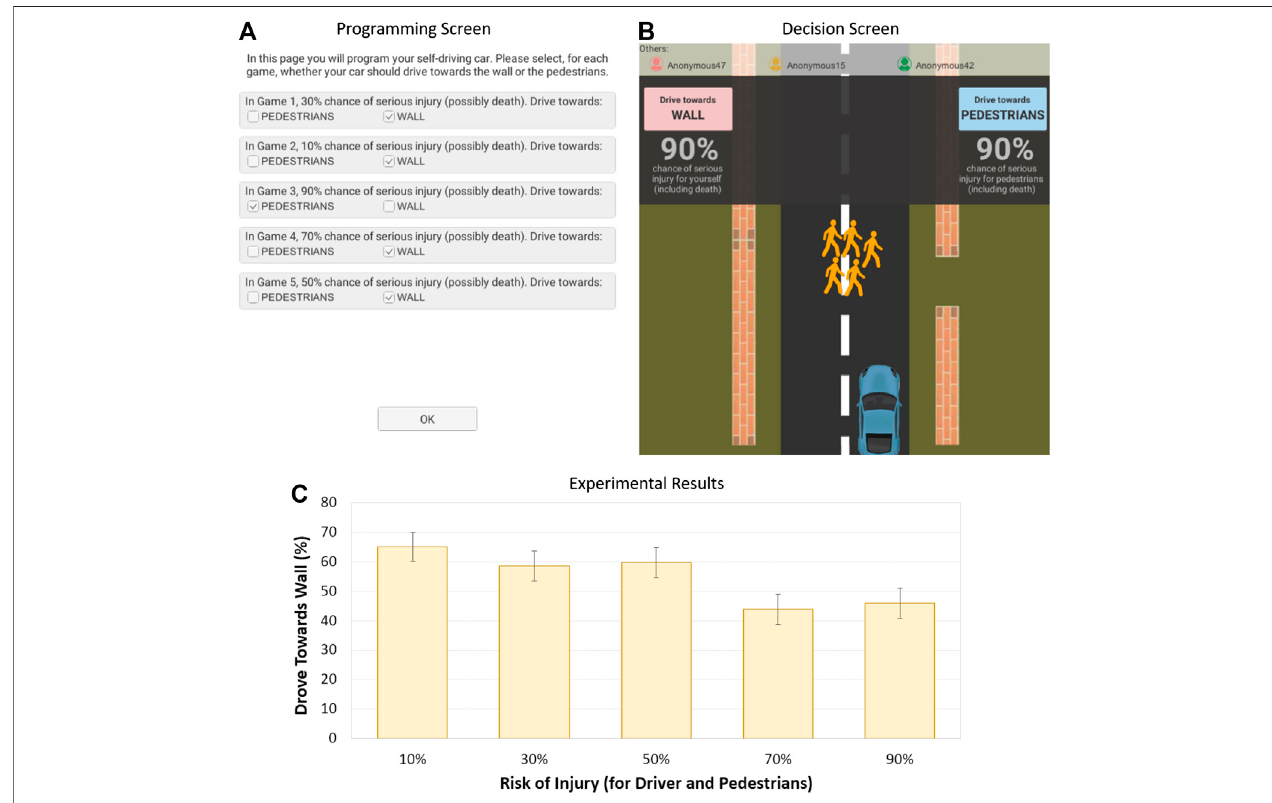
FIGURE 2 | Moral dilemma software and results in Experiment 1: (A) programming interface; (B) decision screen; (C) the in fl uence of risk of injury on utilitarian choice (error bars show standard